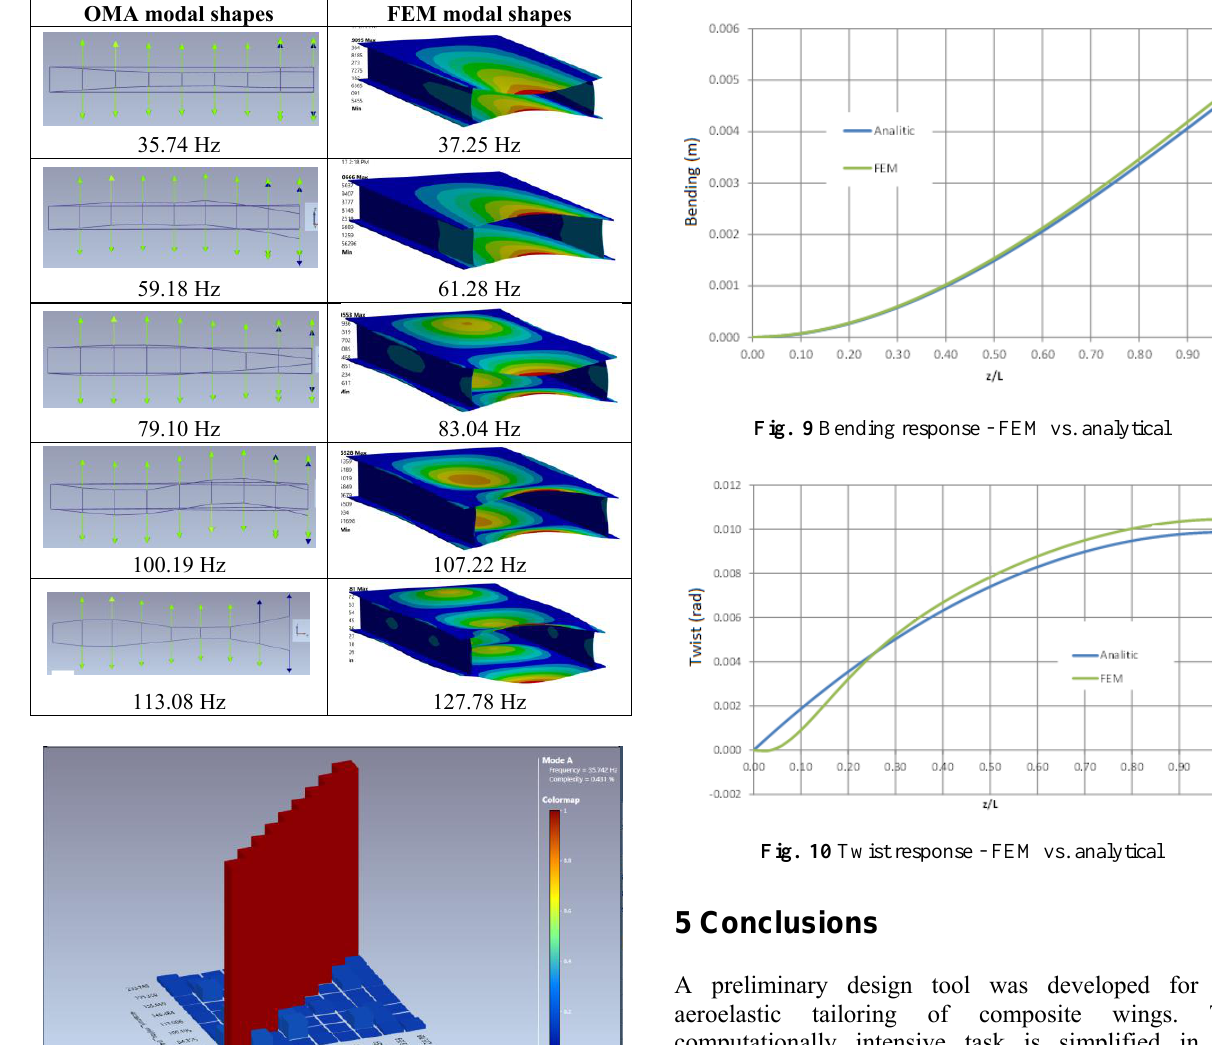
Table 4 FEM updating. The first 4 modal shapes